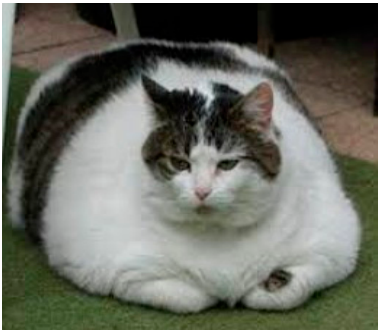
Figure 2. The obese cat.